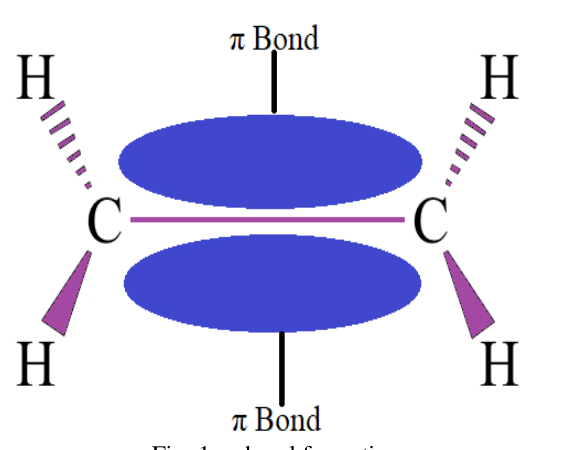
Fig. 1: (cid:1) -bond formation